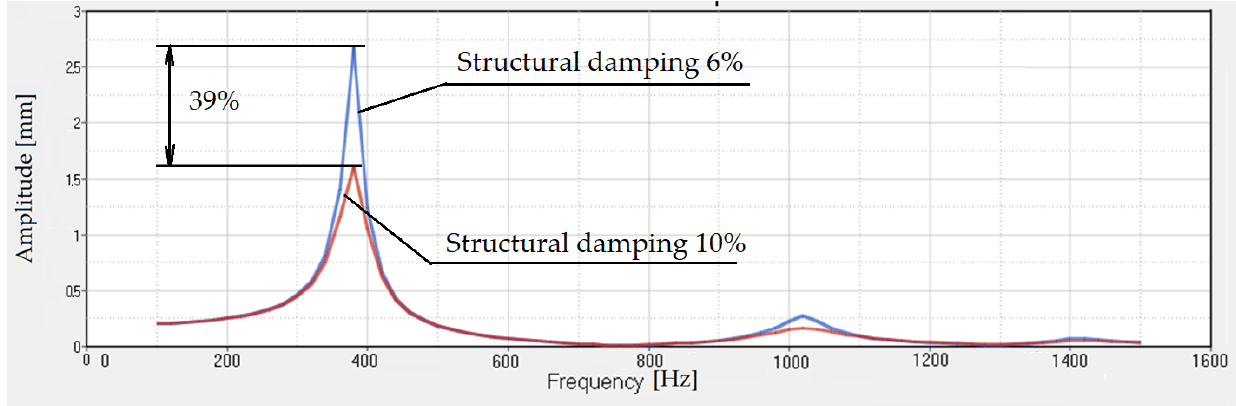
Figure 12. Transmissibility for rubber with voids. The structural damping is 6% and 10%.